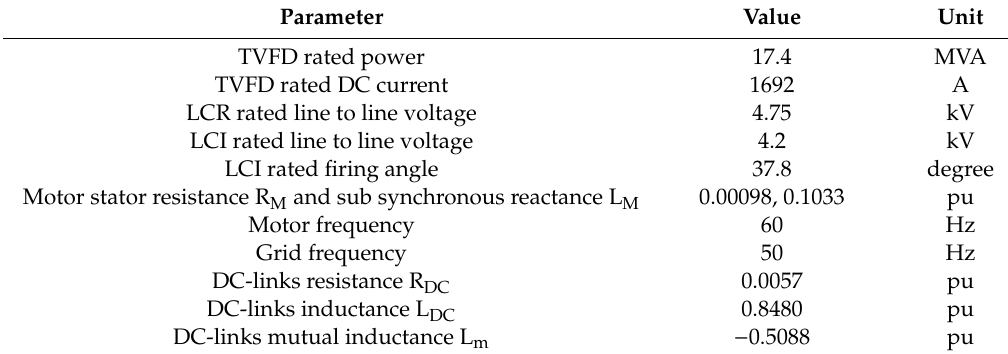
Table 5. PCSs parameters.